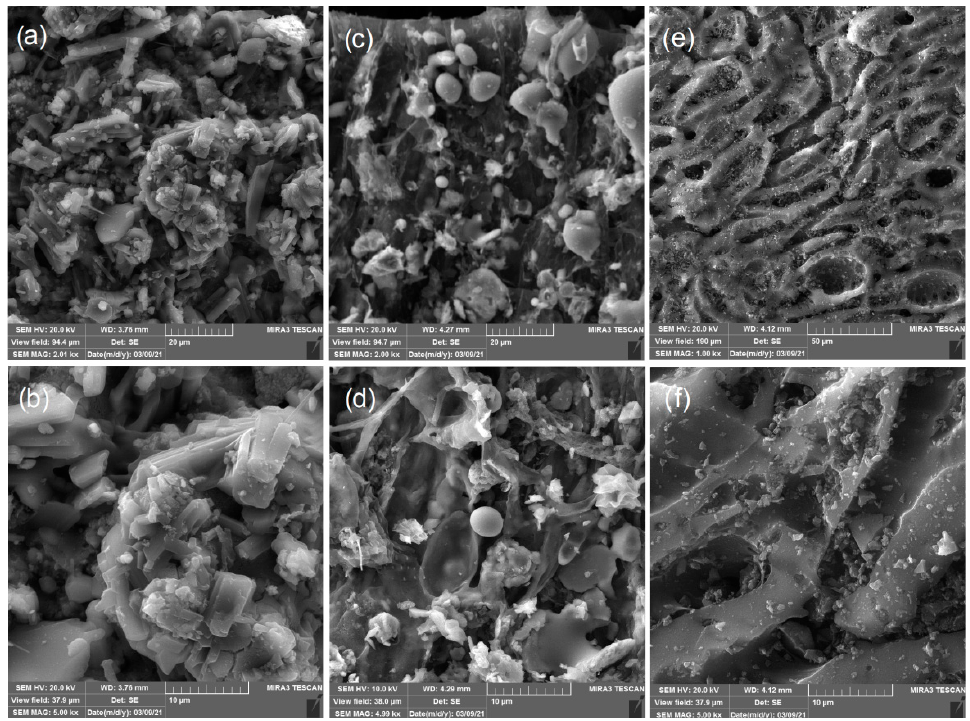
Figure 6. FESEM micrographs at different magnifications of P_AC ( a ) 2000× and ( b ) 5000×; and A_AC ( c ) 2000× and ( d ) 5000×; and C_AC ( e ) 1000× and ( f ) 5000×.